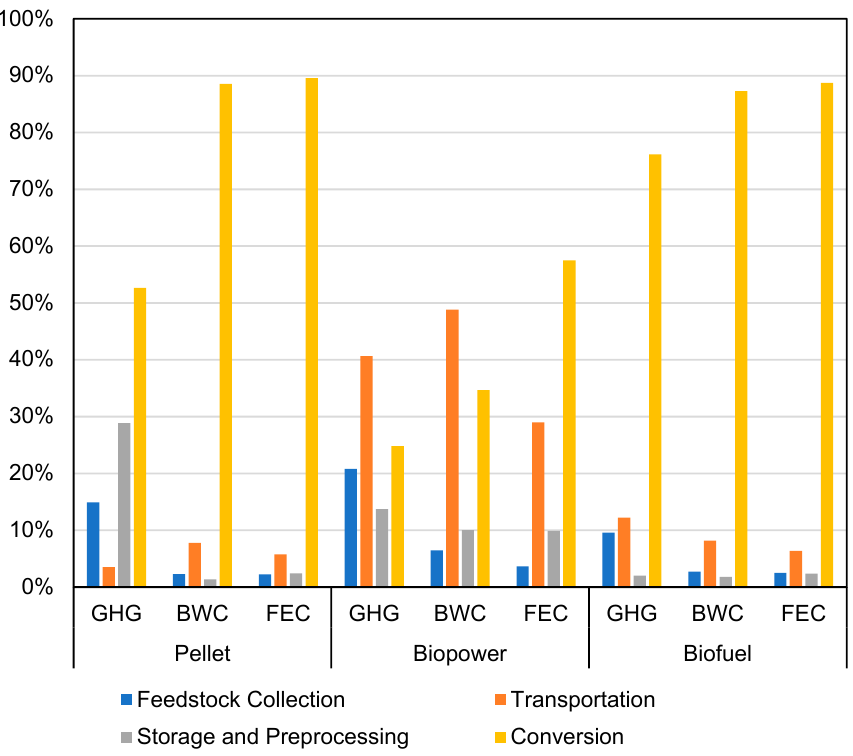
Figure 3. Percentages of the total impact of greenhouse gas emission (GHG), blue water consumption (BWC), and fossil energy consumption (FEC) by supply chain components for pellet, biopower, and biofuel.